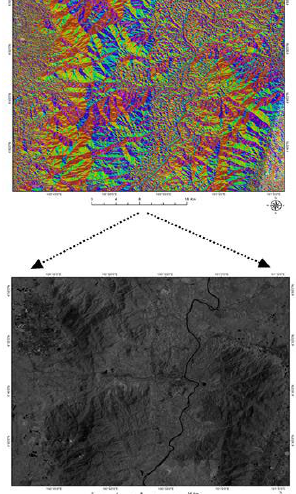
Figure 3: Satellite Image after mergence of principal component, pansharpened data and equalization of histogram.